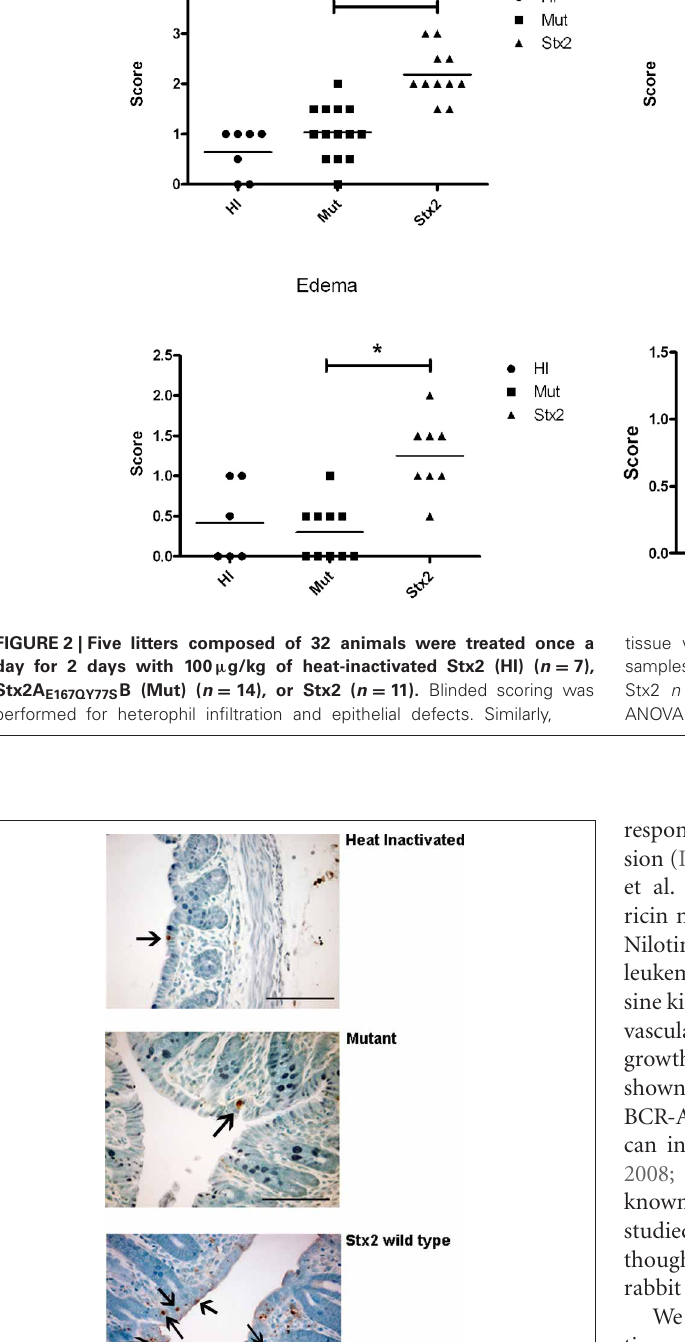
FIGURE 3 | Panels showing representative differences in TUNEL positive cells (arrows) in the colon of heat-inactivated Stx2-, mutant-, and wild type Stx2- treated